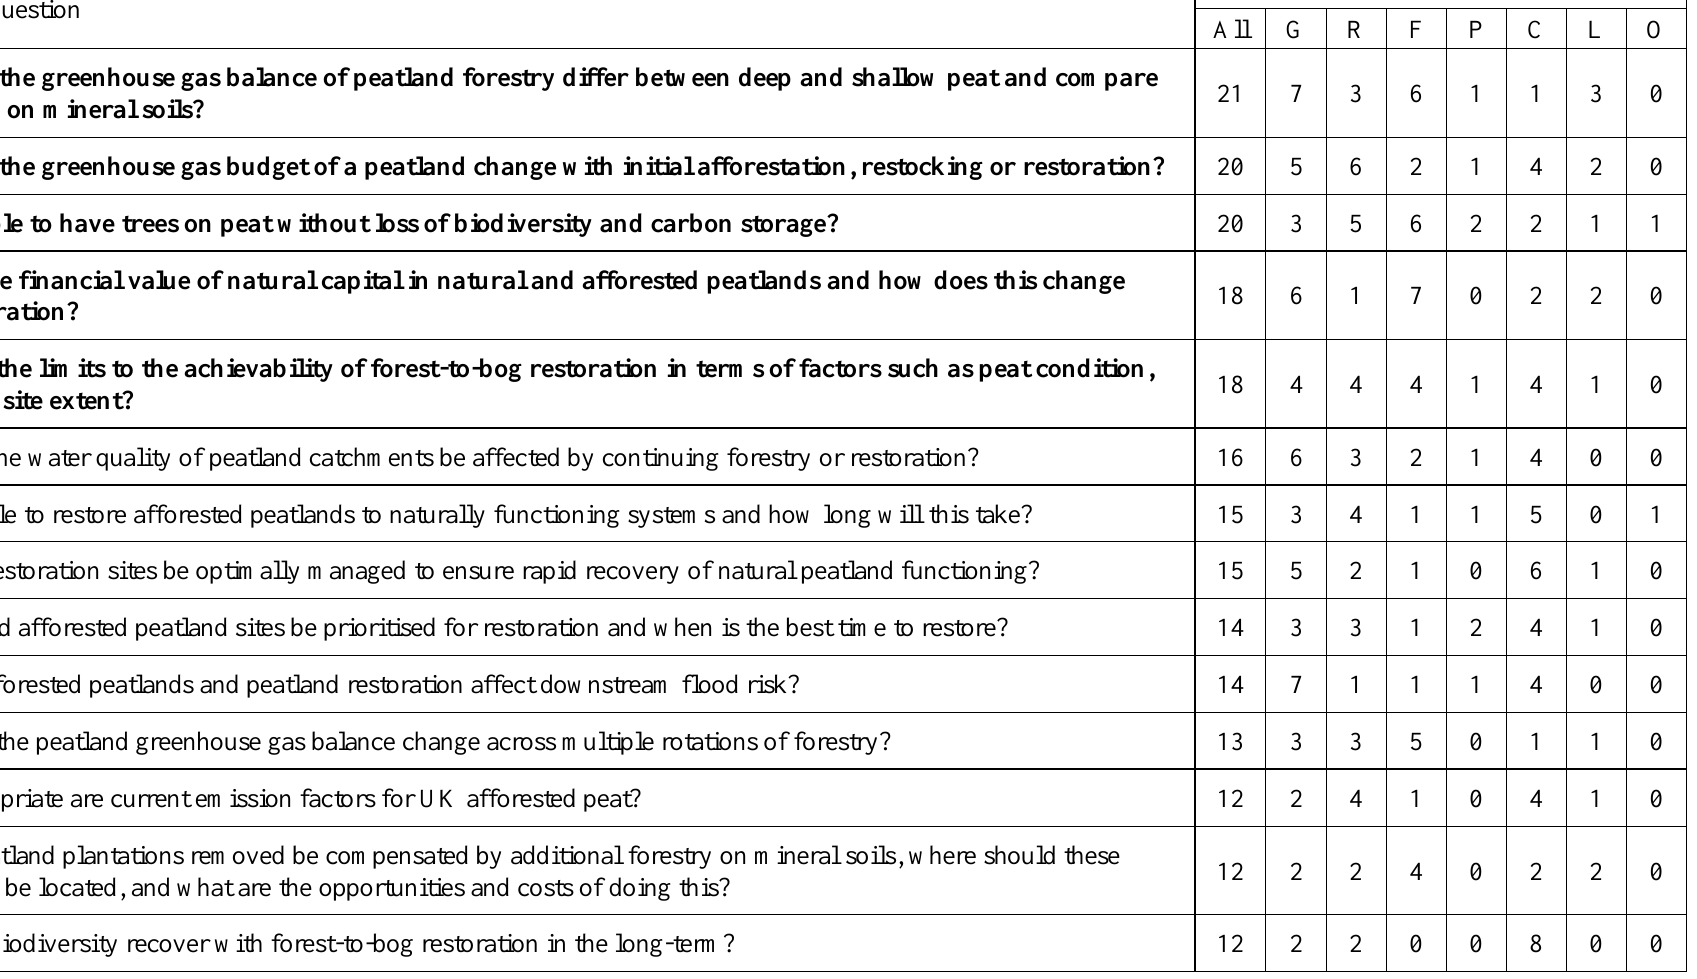
Table 1. Nominated questions and full votes in our survey of key questions. The five most voted-for questions are in bold type. Results are shown in aggregate (‘all’) and by sectors. Key to sectors: G = governmental / statutory body; R = research organisation; F = forestry sector; P = other private sector; C = charitable sector; L = land owners / managers; O =